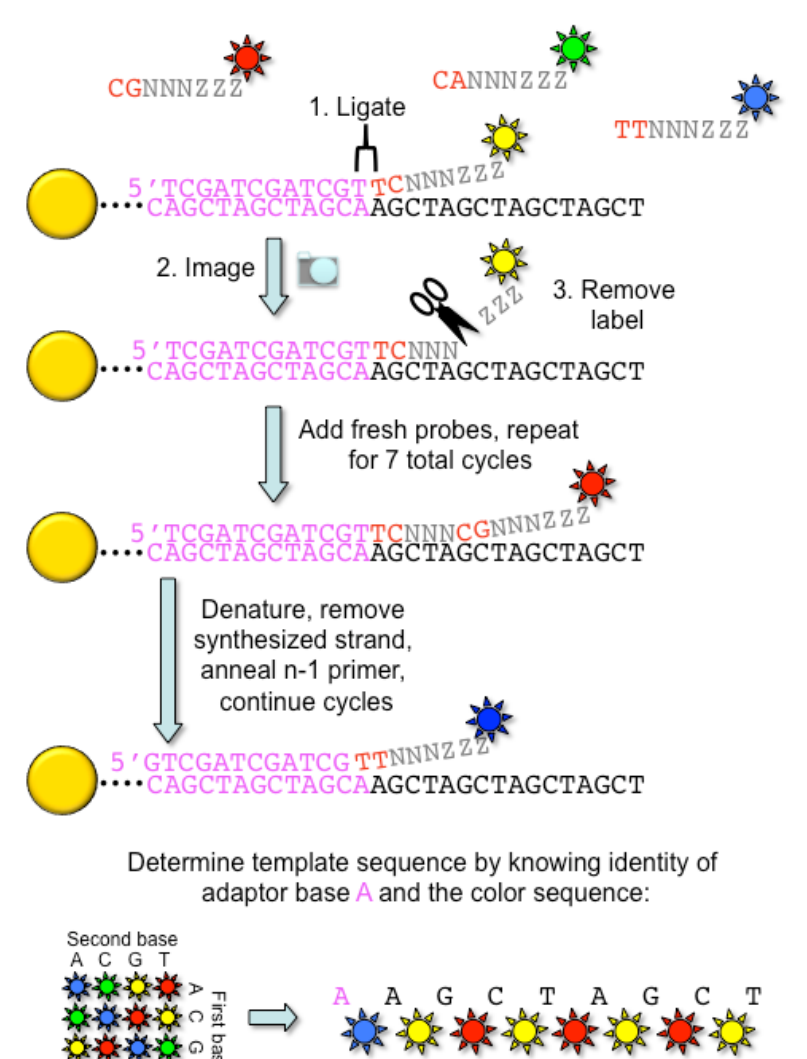
Figure 3. SOLiD ligation sequencing chemistry. DNA templates linked to a capture bead (yellow) are exposed to a mixture of sixteen different oligonucleotide probes encompassing all possible dinucleotide pairs (examples in red). The probes are fluorescently labeled with one of four colors, with each color representing four of the possible sixteen dinucleotide pairs. For example, the color blue represents the monodibase pairs AA, TT, CC, and GG. The remaining nucleotides in the probe are degenerate (NNNZZZ). After successful hybridization of a particular dinucleotide probe to the template sequence, the probe is ligated to the primer oligonucleotide, and the array is imaged. Next, the probe is cleaved, and the fluorescent label is washed away. This cycle of ligation, imaging, and cleavage occur for a total of seven cycles. Next, the newly synthesized strand is denatured and removed, and a new primer (offset by one base relative to the previous primer (n-1 primer)) is annealed to the template. The cycles of ligation, imaging, and cleavage continue for a total of seven cycles for each of 5 primers. The template DNA sequence is decoded by knowing the identity of the adaptor and the sequence of colors recorded from a particular template. As shown in this example, if the first nucleotide of the adaptor sequence is A (pink), and the first recorded color is blue, then the identity of the next base must be an A, as blue represents a monodibase pair. The remaining template sequence can then be deduced in a similar